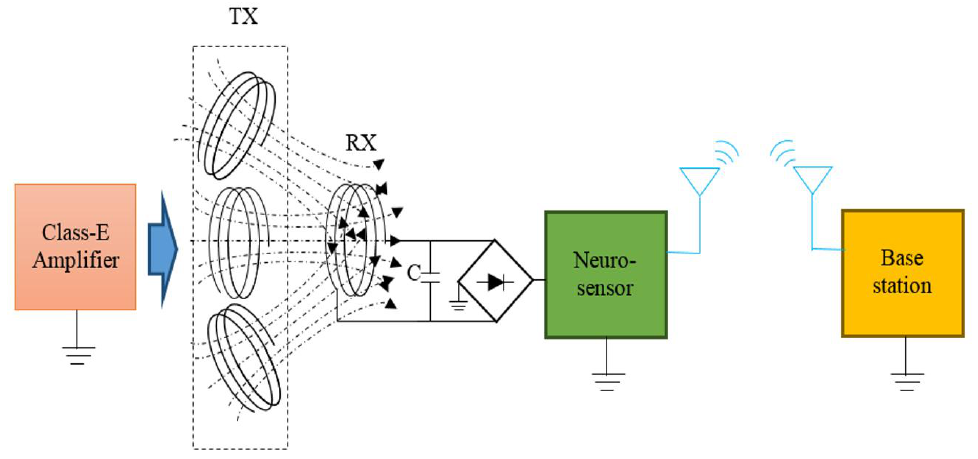
Figure 3. Block diagram of the wireless power harvester for the wearable neurotransmitter sensor